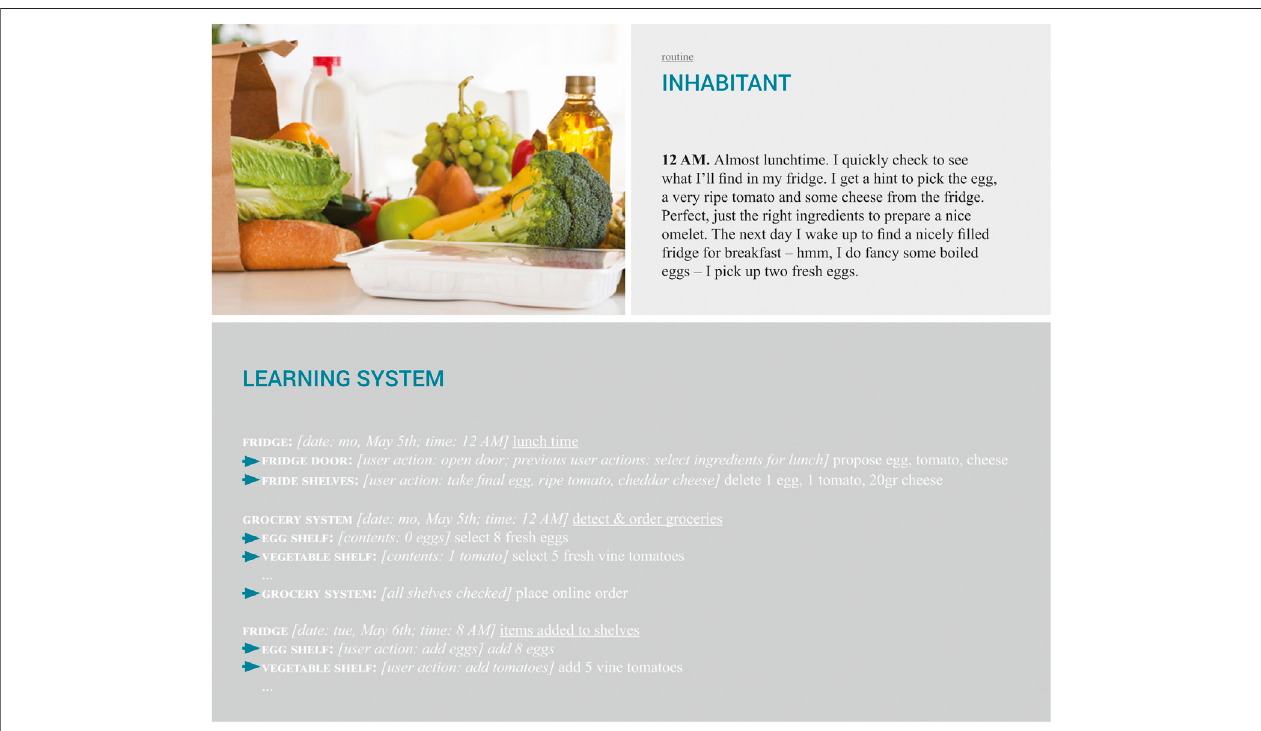
FIGURE 3 | Groceries: routine imaginary (photo by Houston,